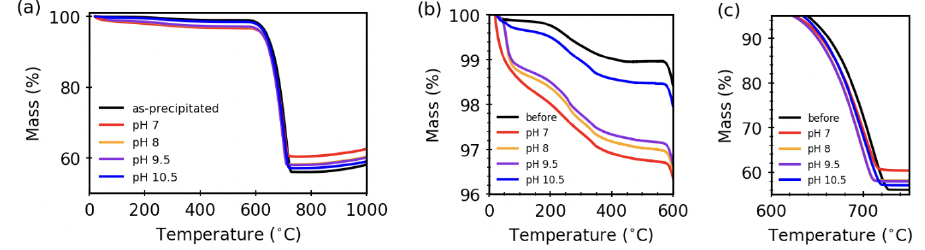
Figure 8. Representative TGA traces compared between as-precipitated and orthophosphate-treated powders during 10 ◦ C/min heating. The full temperature range is shown in ( a ), while ( b , c ) zoom in on the low-temperature and high-temperature transition regions,